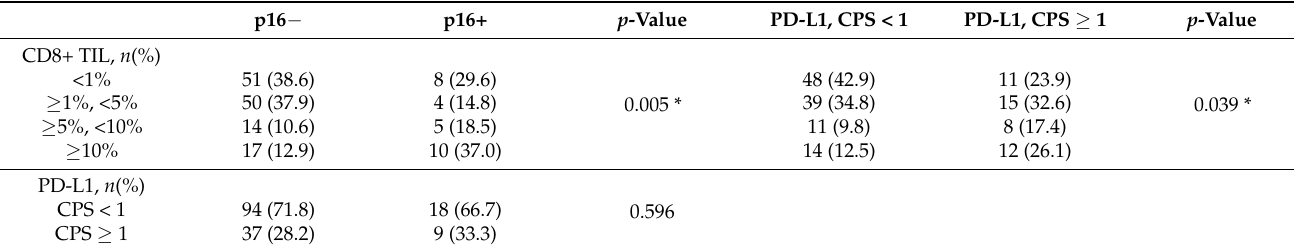
Table 2. Association between p16, CD8+ TIL, and